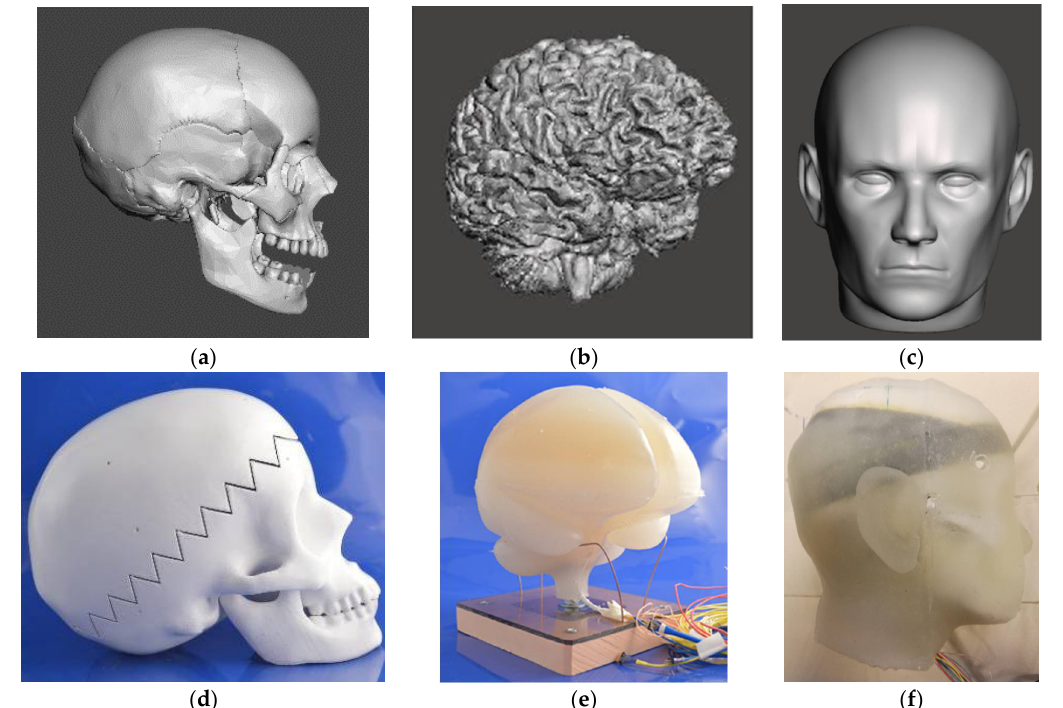
Figure 1. ( a ) Original 3D model of the skull from MRI database; ( b ) original 3D model of the brain from MRI; ( c ) 3D model of the head used for the molds; ( d ) 3D ABS printed version of the simplified skull with the visible suture for insertion of the sensorized brain; ( e ) molded version of the simplified brain with lobe separation and cerebellum (sensor cables coming out from the brain stem); ( f ) complete head with sensorized brain inside and the outer